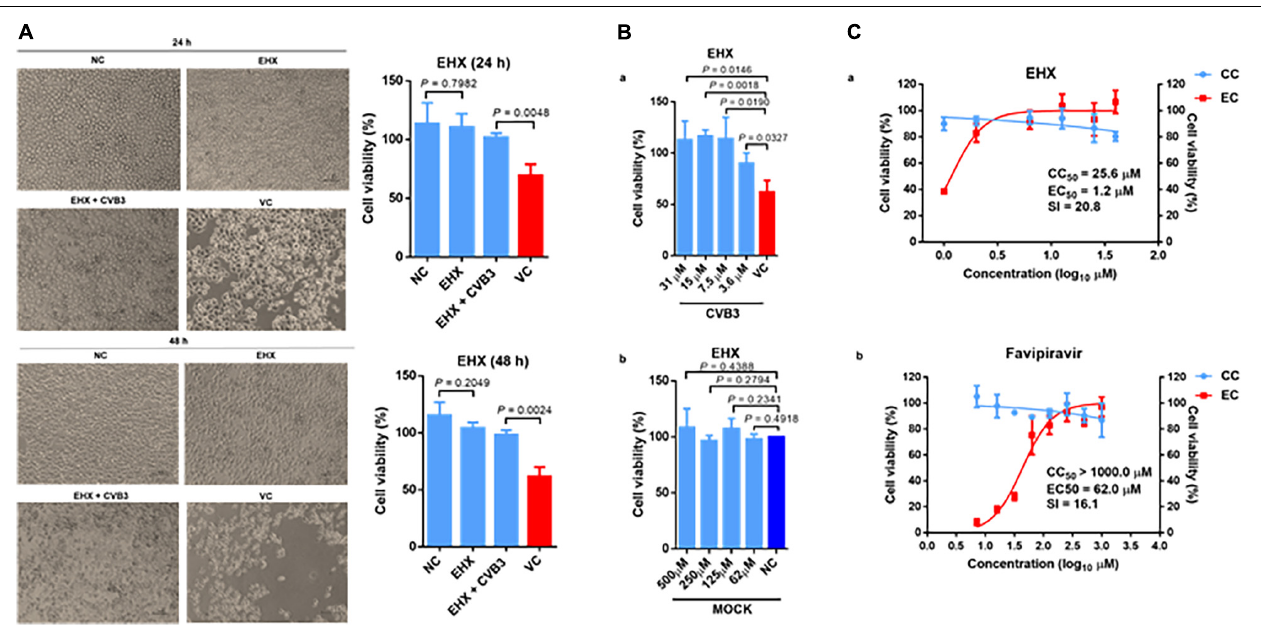
FIGURE 1 | EHX inhibits CVB3-induced cytopathic effect. (A) HeLa cells were infected with CVB3 (MOI = 1) and cultured with medium supplemented with EHX (16 µ M). The cells were examined microscopically (400 × ), and cell viability was analyzed at 24 and 48 hpi. (B) (a) HeLa cells were infected with CVB3 (MOI = 1) and were treated with 5 µ l of the twofold serial dilutions of the compound for 48 h. Cytopathic effect (CPE) was measured by MTT assay. (b) HeLa cells were treated with 5 µ l of the twofold serial dilutions of EHX for 48 h, and CPE was measured by MTT assay. (C) EC 50 and CC 50 of EHX and Favipiravir. Twofold serial dilutions of the test compounds were added to virus-infected HeLa cells for 72 h, and the inhibitory effects were analyzed by a CPE assay. Cytotoxicity was examined by incubation of HeLa cells with the indicated concentrations of compounds without the addition of virus. Cell viability was measured by MTT assay and was presented as the percentage of absorbance. CC 50 and EC 50 were calculated using non-linear regression (GraphPad Prism 6). Error bars represent SD, n = 3, Student’s t -test. EHX: ethyl 3-hydroxyhexanoate, VC, virus control; CC, cytotoxicity; EC, effective concentration; SI, selective index; CVB, Coxsackievirus B; NC, negative